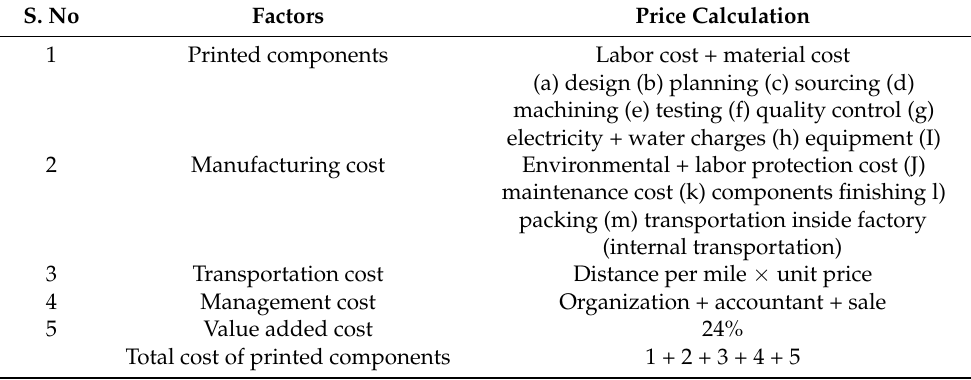
Table 10. Cost calculation factors in the